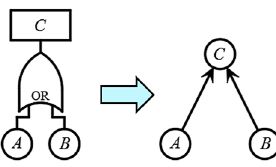
Figure 1. AND gate and its corresponding CTBN representation